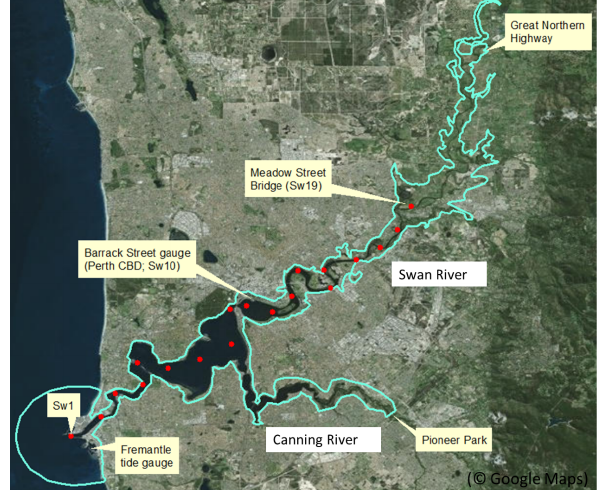
Figure 4. Model extent and key locations for the case study system. The blue line represents hydrodynamic model extent. The red dots represent the 19 locations where flood level results are extracted, from Sw1 at Fremantle to Sw19 at Meadow Street Bridge. (This figure was created using © Google